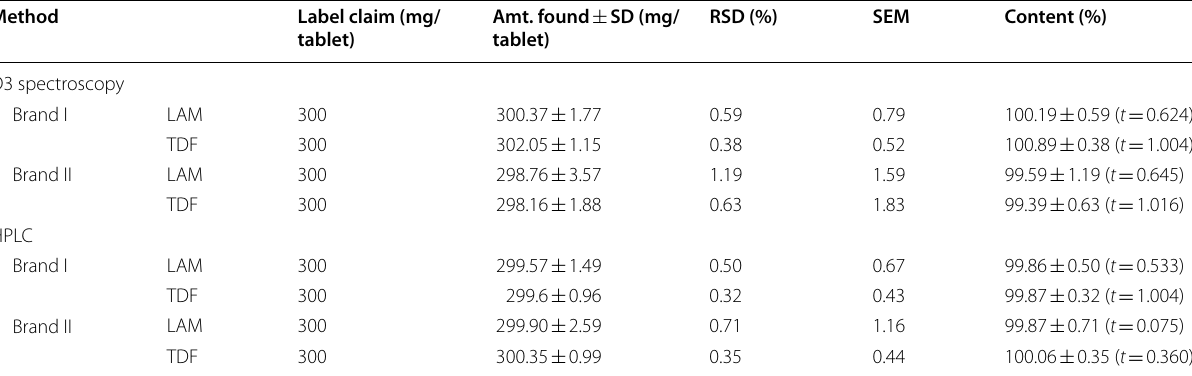
Student t -test is with respect to the label claim of each drugs; t -distribution at 95% confidence limits is 2.776 for n Table 6 Paired t -test/ F -test for D methods Method/